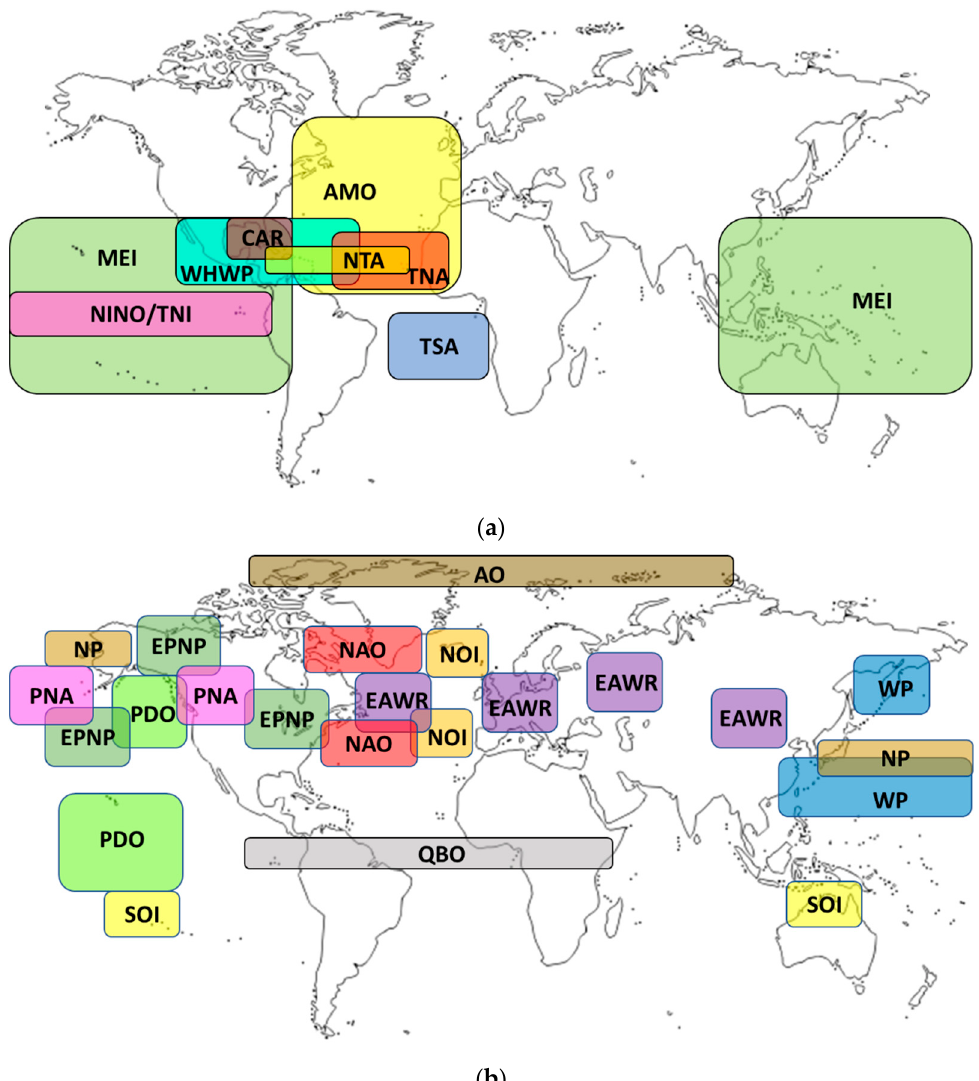
Figure 1. Locations characterized by various climate indices in terms of ( a ) SSTs and ( b ) atmospheric behavior (i.e., pressure and height anomalies). The CIs indicated by each abbreviation are defined in Table 1.